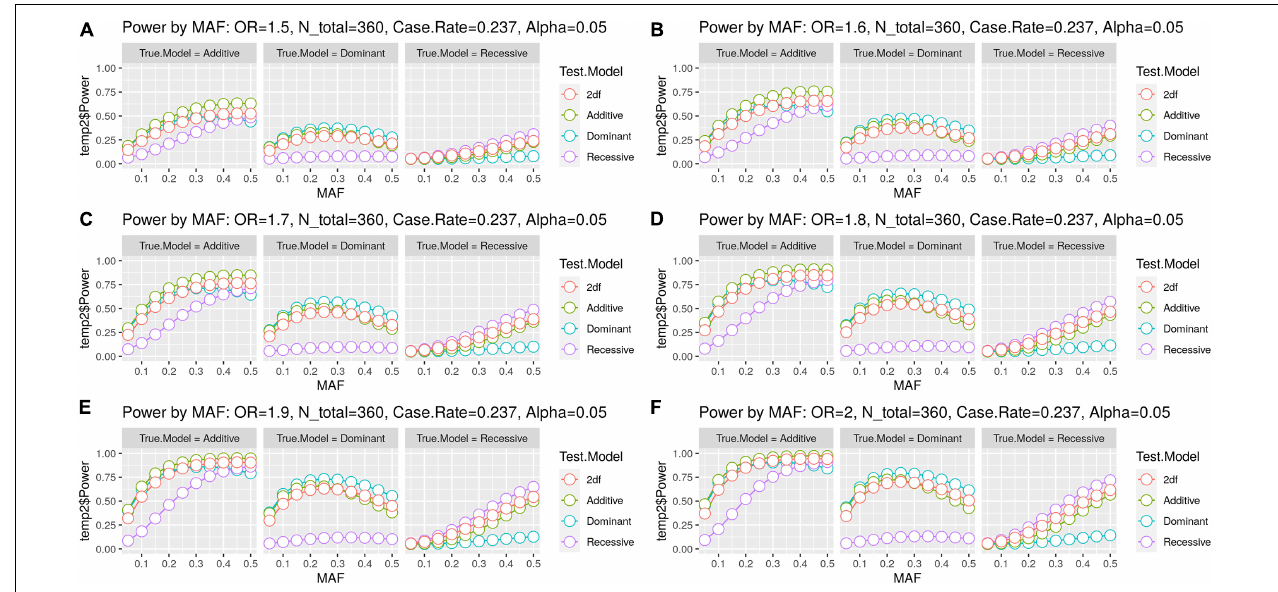
FIGURE 2 | Statistical power estimation. The figure includes six panels (A–F) for the six OR values evaluated. Each panel shows the statistical power ( y -axis) estimated by minor allele frequency (MAF) ( x -axis) for the combination of the three true genetic models (Dominant, Additive, and Recessive) with the four test models (Dominant, Additive, Recessive, and 2df/unspecified genetic model). Each colored line represents the test model, and each point represents the MAF.